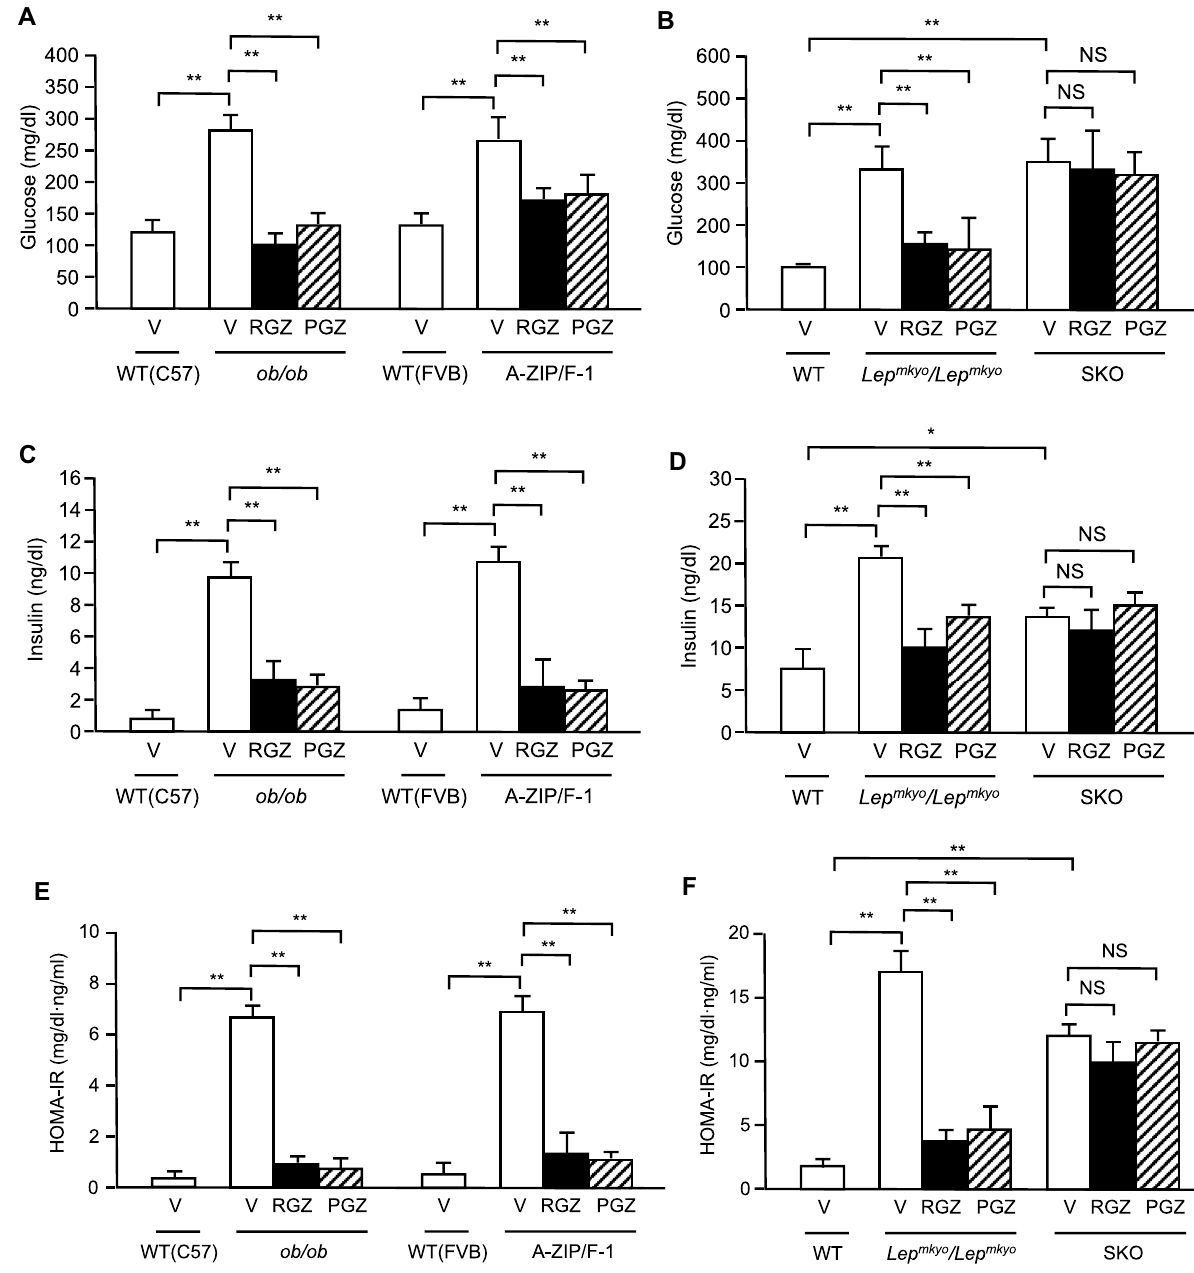
Figure 4. Effect of TZD treatment on glucose metabolism in mouse and rat models of leptin deficient obesity and generalized lipodystrophy. ( A , B ) Plasma glucose and ( C , D ) insulin concentrations in C57B/6J WT, ob/ob , FVB/N WT and A-ZIP/F-1 mice ( A , C ) and F344 WT, Lep mkyo /Lep mkyo and SKO rats ( B , D ) treated with vehicle, RGZ or PGZ. Values are means ± SEM ( n = 10 per group). * P < 0.05, ** P < 0.01, NS, not significant (one-way ANOVA followed by Tukey’s